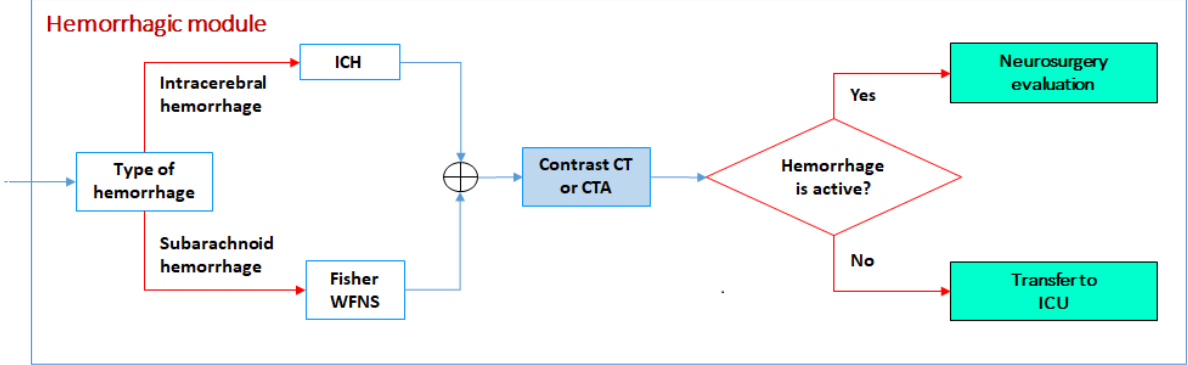
Figure 7. Hemorrhagic module. CT: computed tomography; CTA: computed tomography angiography; ICH: intracerebral hemorrhage score; ICU: intensive care unit; WFNS: Modified World Federation of Neurosurgical Societies.